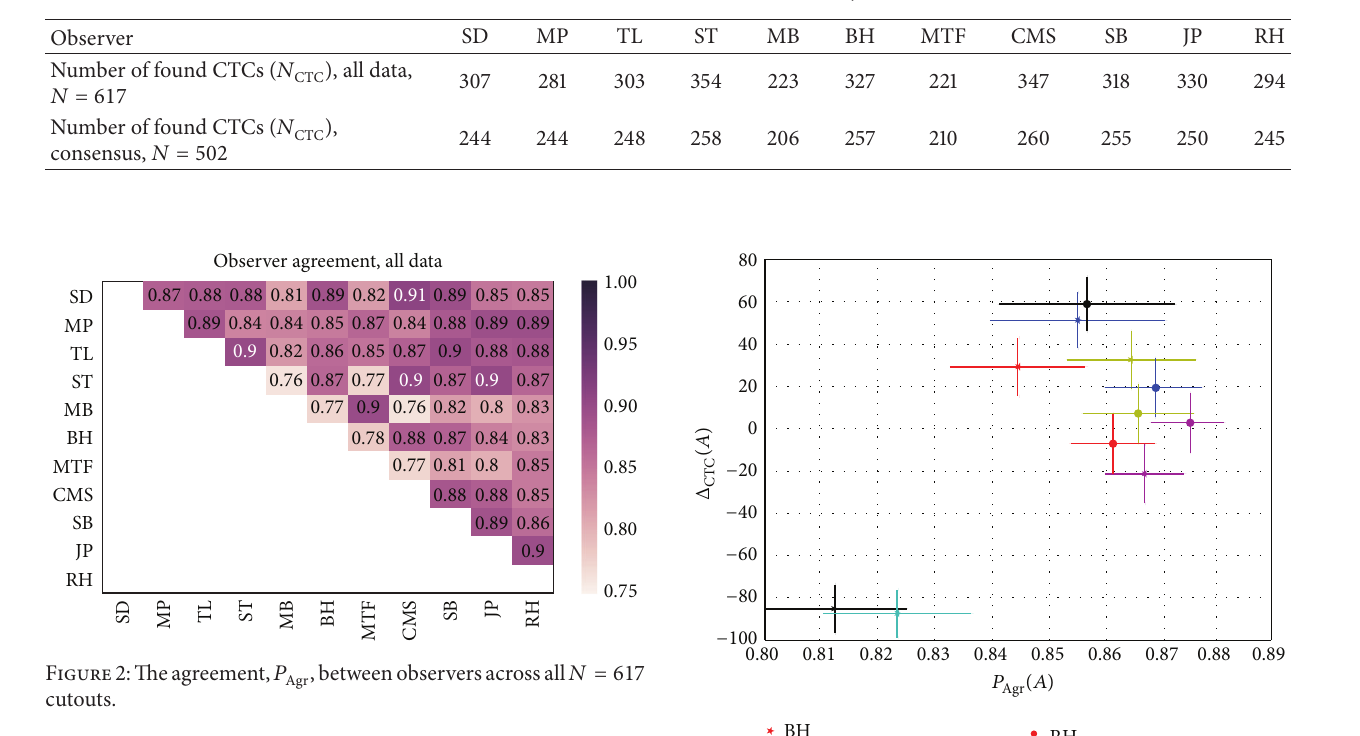
Table 1: The number of CTCs identified in the data set by each observer.